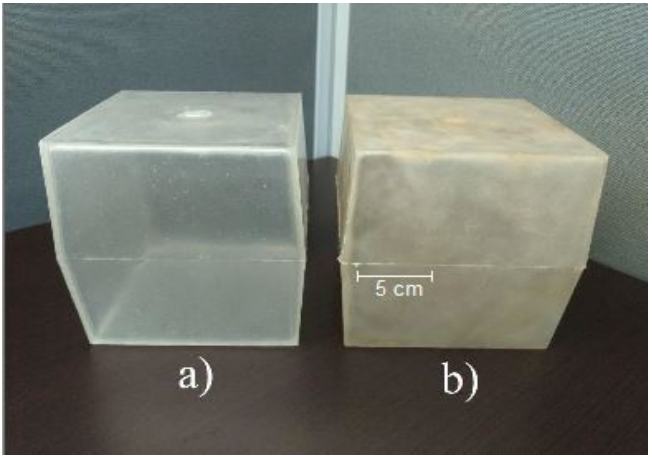
Figure 4. Rotomolded PLA pieces prepared by ( a ) DB and ( b ) MB. Optical micrographs of the internal surface of the rotomolded parts prepared by DB are shown in Figure 5 (left column). In these samples, particles of the minor phase have a spherical shape and present a broad size distribution with an average around 500 µ m (initial particle sizes). It has been widely reported that this is a typical morphology of immiscible polymer blends [5,33,40,41], where large domains are obtained due to polymer incompatibility and lack of shear during mixing. On the other hand, SEM micrographs were taken to observe the state of disper- sion/adhesion of the phases in the blends prepared by MB. Figure 5 (right column) shows the SEM micrographs of cryo-fractured parts. It is clear that MB generates smaller particle sizes of the dispersed phase (for example PLA75 have a particle size of 16.2 ± 9.8 and PLA25 of 7.1 ± 4.3 µ m) due to the higher stresses involved in the extruder. In all cases (DB and MB), a weak interfacial adhesion was produced between the PLA and LMDPE since no compatibilizer was